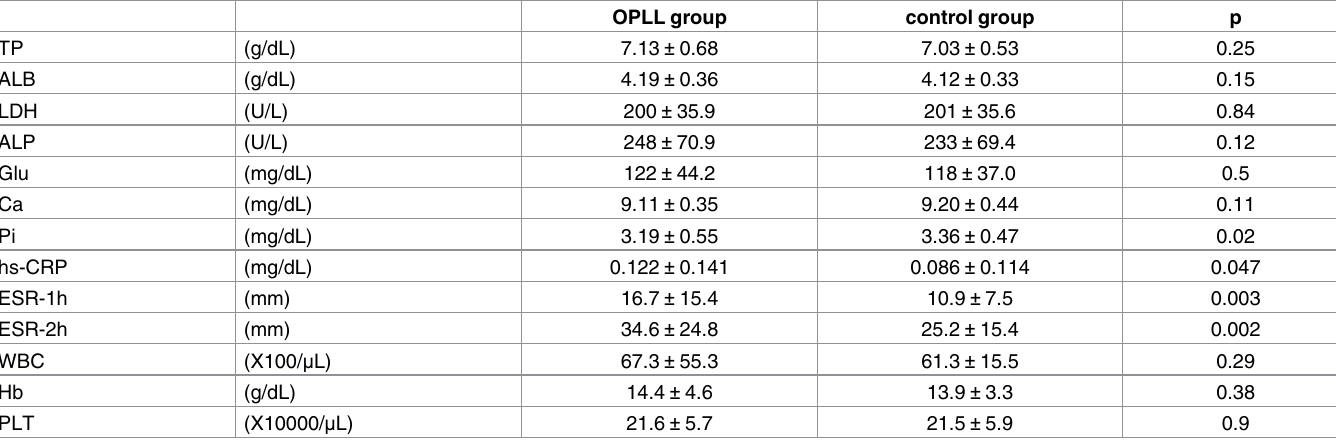
Table 2. Comparison of the biomarkers between the patients with OPLL (case) and the controls.